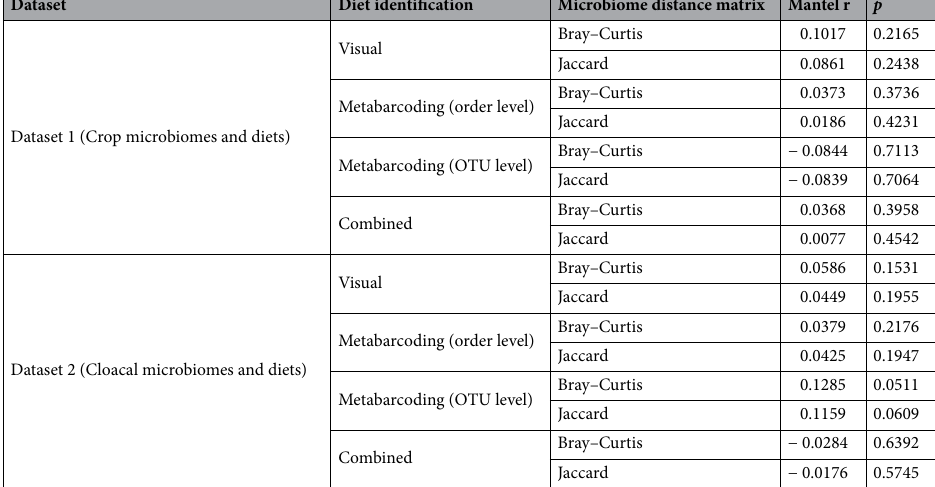
Table 2. Results of Mantel tests between the crop (dataset 1) and the cloacal (dataset 2) microbiome similarities (measured with both Bray–Curtis and Jaccard distances) and the consumed diet similarities (measured with Jaccard distances). Separate tests were conducted for visual, metabarcoding (both at diet OTU and order level) and the combined identification of